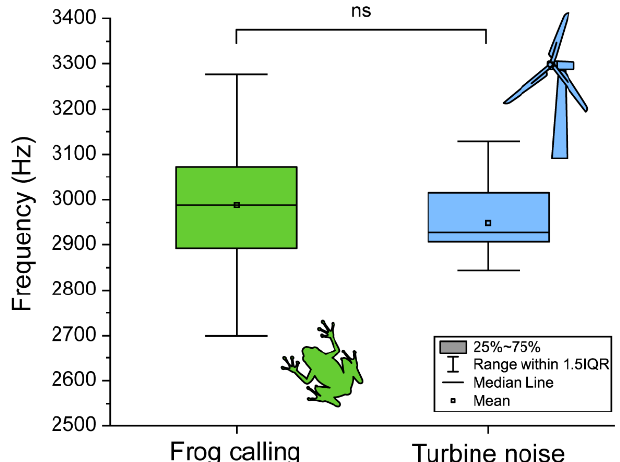
Figure 4. The comparison between the frequency of frog calling (green box) and wind turbine noise (blue box). Box plots show the mean (central square dot), median (central line), 25th and 75th percentiles (bottom and top of boxes), and range within 1.5 interquartile (bottom and top of line). The temperature, humidity, and illuminance (not possible to compute a t -test because of the same value) were not significantly different between the control and wind turbine groups’ sites. Similarly, there was no significant difference in the chorus size, which indicates the density of males during the breeding season. In contrast, the background noise was found to have a significant difference ( t (16) = 18.32, p < 0.05) between sites with and without wind turbines (Table 1). The SVL, body weight, fat content mass, fat content ratio, lean body content mass, lean body content ratio, and BMD did not differ significantly between the field investigation groups (control and wind turbine group) and noise exposure conditions group (Table 2). Table 1. The comparison of environmental conditions (temperature, humidity, illuminance, chorus size, and background noise in the presence of wind turbines) between control and wind turbine groups. Significant differences ( p < 0.05) were determined using an unpaired t -test and are represented with asterisks (*).